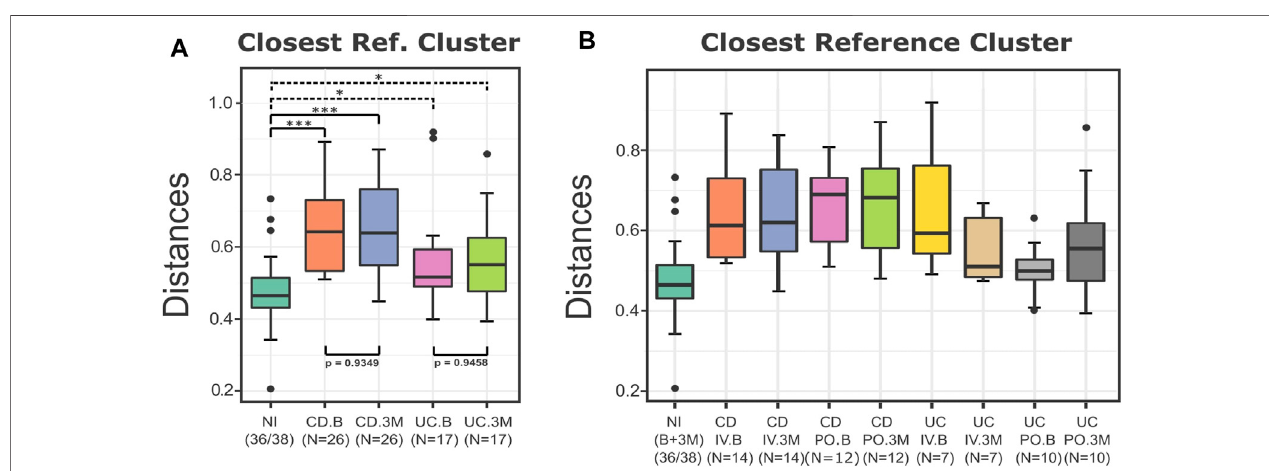
FIGURE 4 | Boxplots of the distances of the test groups from the closest reference medoid of the NI group. (A) For the UC and CD groups, the type of the disease and the sampling time did not affect their distances from the NI samples. All the groups were signi fi cantly farther from the control group compared to the reference samples( p < 0.05).ThedistancesoftheCDpatientsfromthecontrolgroupseemtopresentoverallhighervaluesthanthedistancesoftheUCpatientsfromtheNIgroup. (B) All the IBD samples were grouped based on the type of the disease, the treatment, and the sampling time. The boxplots of the distances from the closest medoid indicate that the CD groups have a higher level of homogeneity but are farther from the control group compared to the UC groups. On the contrary, most of the UC samples are closer to the NI group, but their distances from the reference group present a higher variance. In particular, the distances of the UC.PO.B group are related to the NI group ( p = 0.34). p -values: * < 0.05; *** <